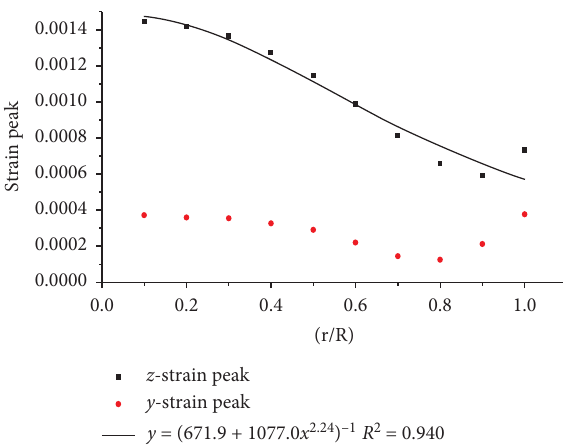
Figure 19: Distribution of the axial and radial strain stress peak, and the axial strain peak is greater than the radial strain peak. The strain near the edge on the radial line in- creases due to the unconstrained edge and greater defor- mation under the same force.